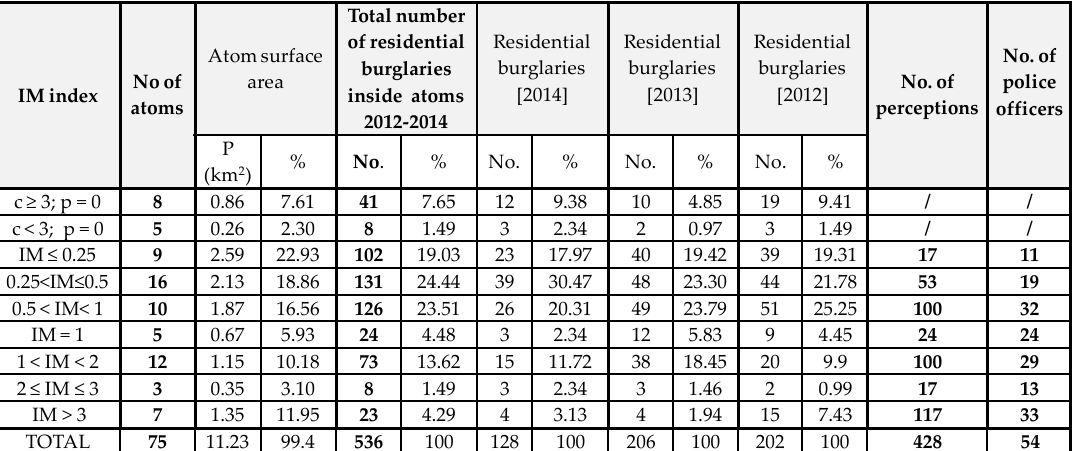
Figure 2. Di ff erent index measure (IM) values in the research area. Figure 2. Different index measure (IM) values in the research area.